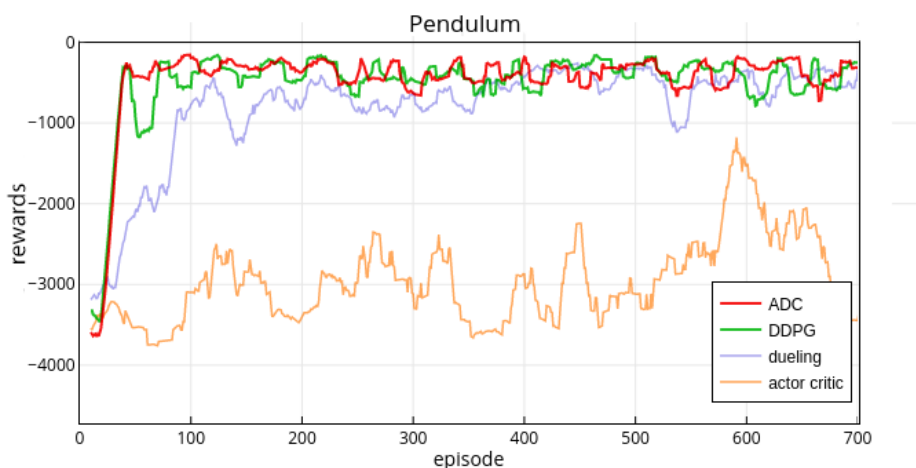
Figure 4. ADC, DDPG, dueling and actor-critic’s performance in the gym Pendulum-v0 environment. The x-axis represents the episodes and y-axis represents the cumulative rewards per episode. Table 1 lists important hyper-parameters.